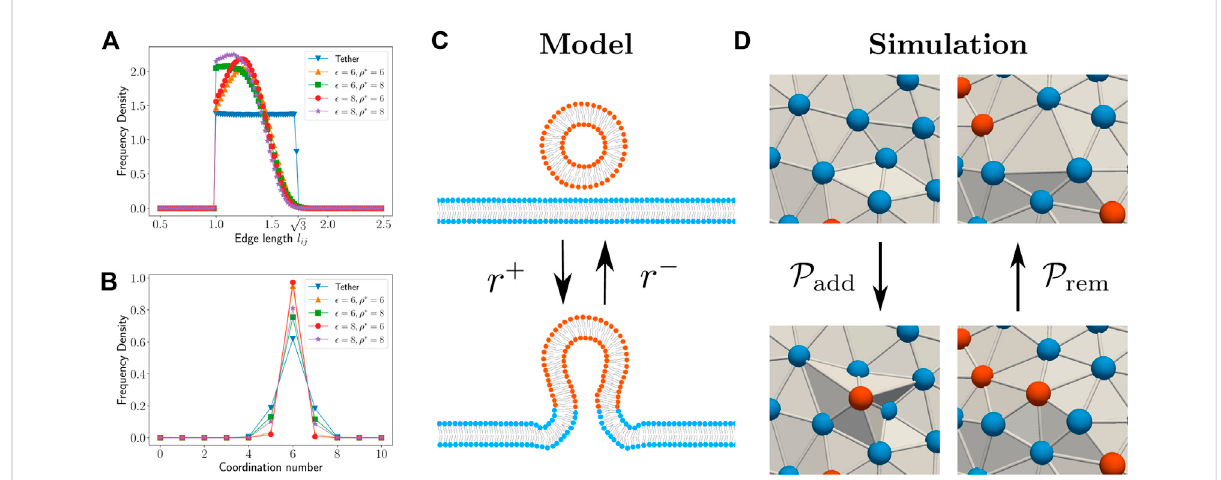
FIGURE 1 Thehistogramforedgelength (A) andcoordinationnumber (B) distributionfordifferentparameterchoicesforthelocaldensitybasedpotential in our modi fi ed DTMC technique. The histograms for the conventional DTMC technique is shown as “ Tether ” for comparison. (C) Schematic representation of fi ssion/fusion process in ourmodel.The fi ssion/fusion process takes place with rates r − / r + respectively. (D) Schematicshowing the local con fi gurational changes during vertex addition and removal MC moves in the